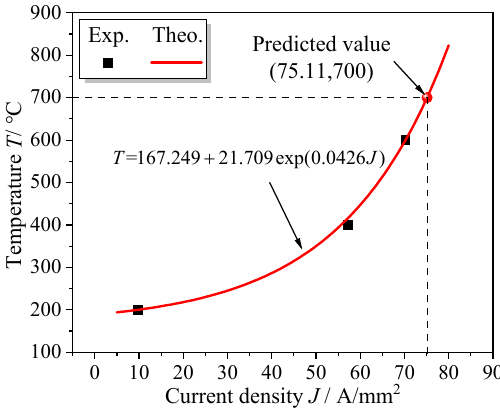
Figure 8. Relationship between temperature and current density.